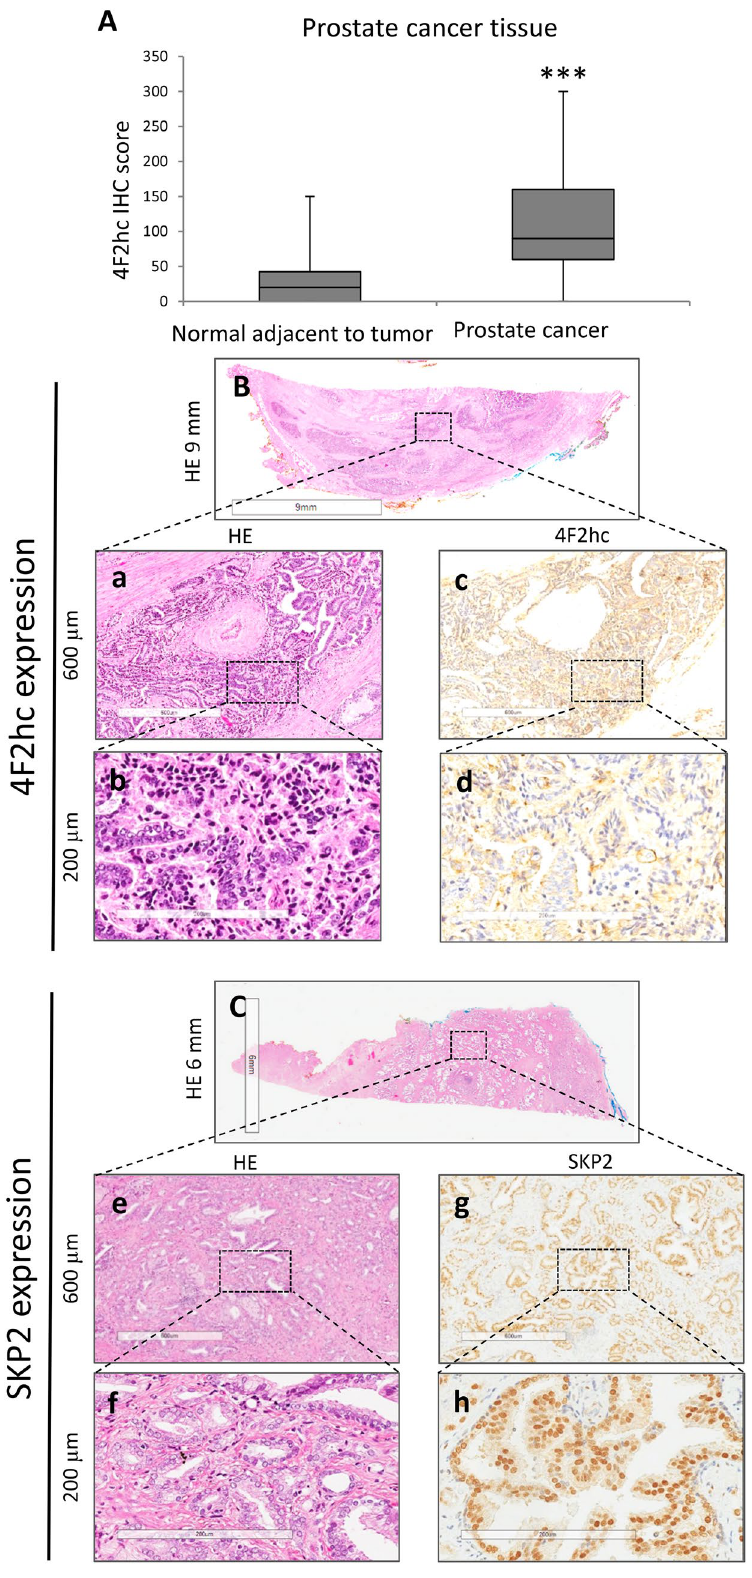
Figure 5. Representative staining pictures showing 4F2hc and SKP2 expression in PC tissues. Quantification of 4F2hc staining of NAT and PC tissues. The 4F2hc IHC scores levels are shown in normal prostate tissues and PC ( A ). 4F2hc and SKP2 expression in PC tissues was analysed by immunohistochemistry. Sections were stained with haematoxylin and eosin ( B ; a: 600 µm and b: 200 µm and C ; e: 600 µm and f: 200 µm). Representative images of 4F2hc immunohistochemical expression (c: 600 µm and d: 200 µm) and representative images of SKP2 immunohistochemical expression (g: 600 µm and h: 200 µm). Representative staining images are